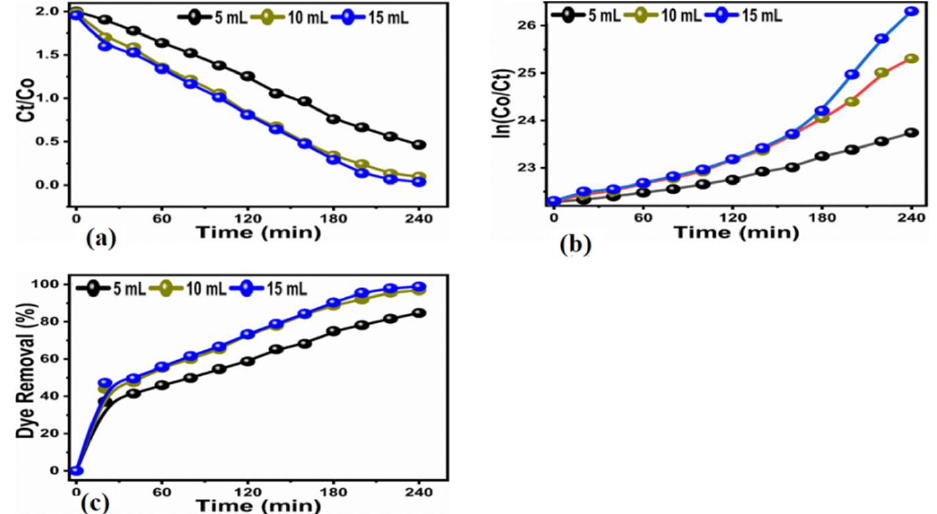
Figure 9. ( a ) Plot of Ct. Co verses irradiation of photodegradation of MB at various times ( b ), pseudo-first order plot for photodegradtion of MB ( c ) and the calibration curve of dye removal (%) under natural light illumination of bulk TiO 2 material that has been hydrothermally treated with 5, 10, and 15 mL of FC leaf extracts at 20–240 min.